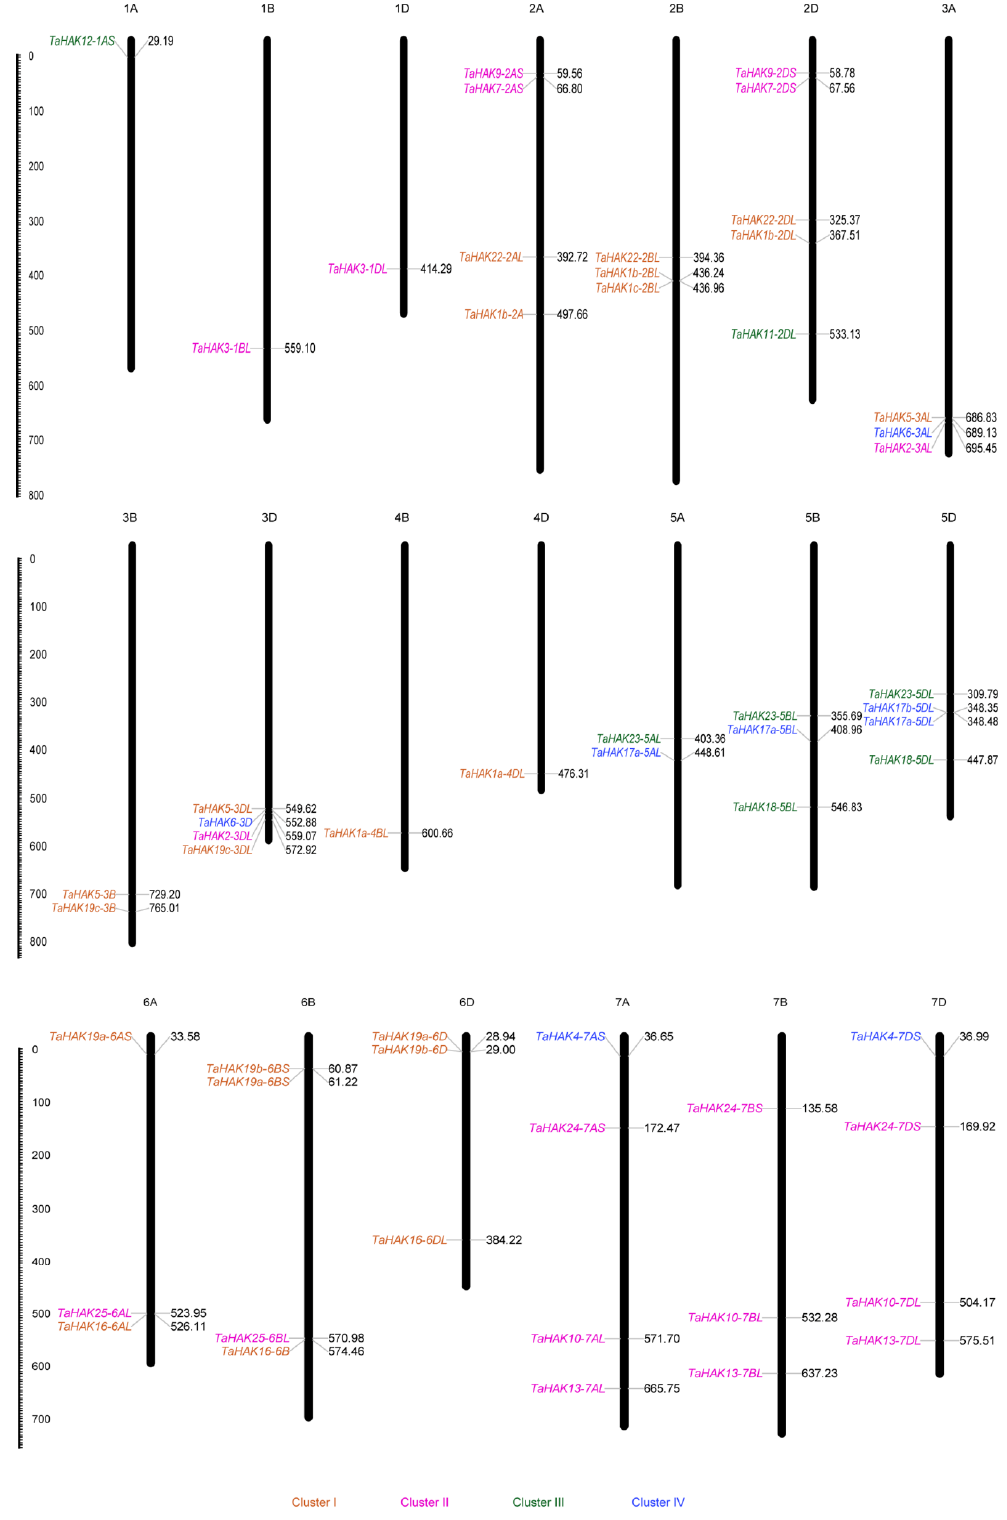
Figure 2. Chromosomal distribution of TaHAK genes . The names of chromosomes are shown above each chromosome. The gene names are indicated on the left side and the starting locations are on the right of chromosomes. The TaHAKs in each cluster are specified by the same color. The lengths of chromosomes are shown in Mb (Millions of bases).